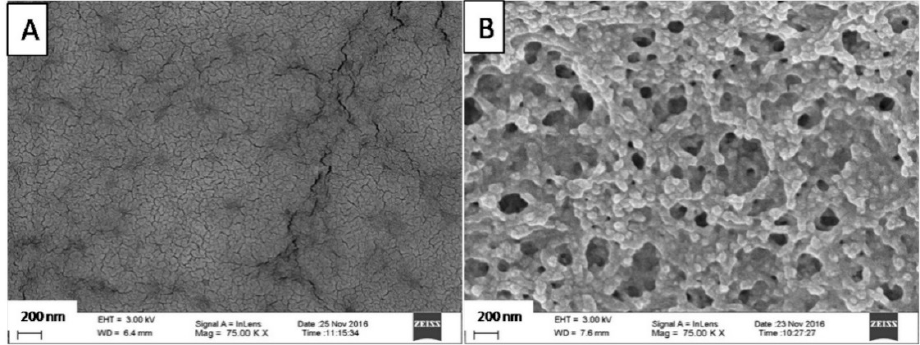
Figure 2. Modified filmsGA1 (30% Aquacoat) before ( A ) and after 3 h in acid ( B ). Scale bar—200 nm.